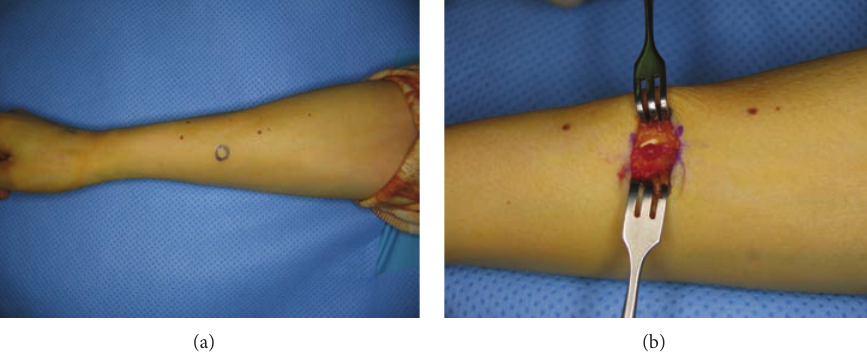
Figure 2: (a) Intraoperative gross photograph showing the focal area of tenderness, which was marked before incision. (b) An oval-shaped, well-encapsulated mass was exposed through careful dissection, and was identified to be lying in a branch of the cephalic